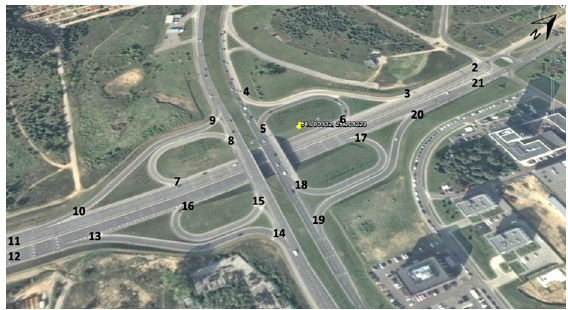
Fig. 6. The general view of the analysed transport nodal point